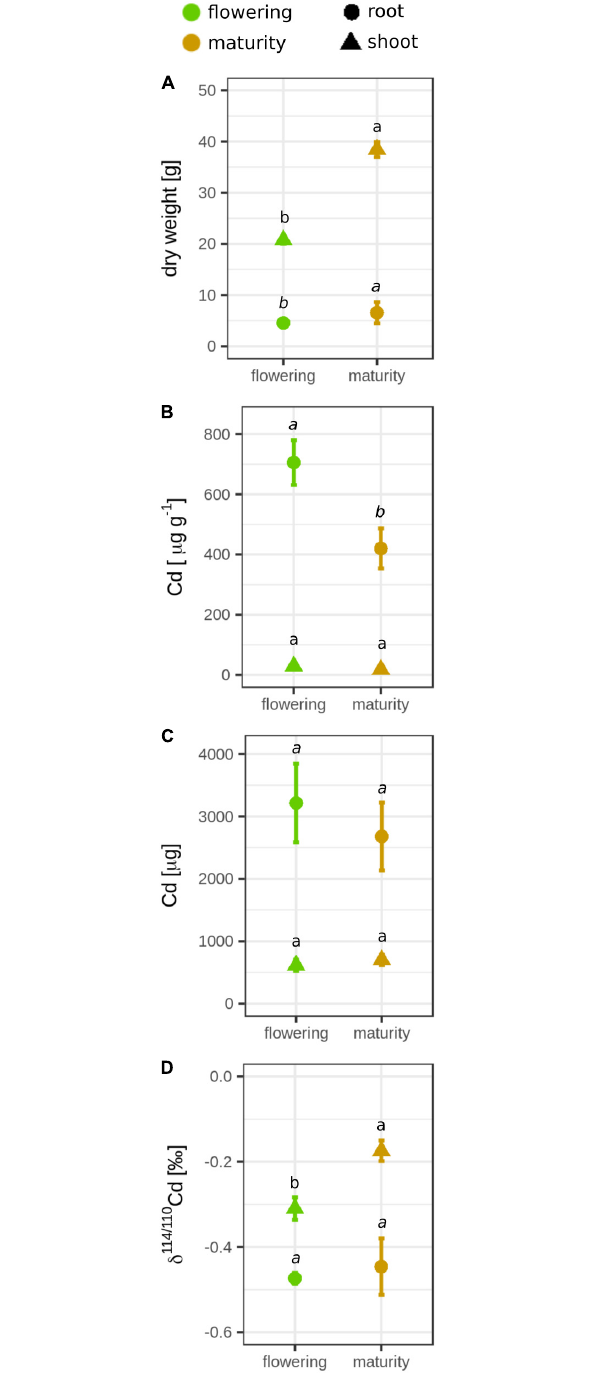
FIGURE 2 | Mean (A) dry weight (DW), (B) cadmium (Cd) concentration, (C) Cd mass, and (D) Cd isotope ratio of the roots and shoots of rice plants that were harvested at flowering and maturity. Error bars represent the standard deviation of n = 4 experimental replicates. Letters denote significant differences of the mean (regular = shoot, italic = root) that were determined by either a [ B,C (root), D ] Welch’s t- test or [ A,C (shoot)] Wilcoxon rank sum test. Data from the flowering growth stage were published previously (Wiggenhauser et al.,